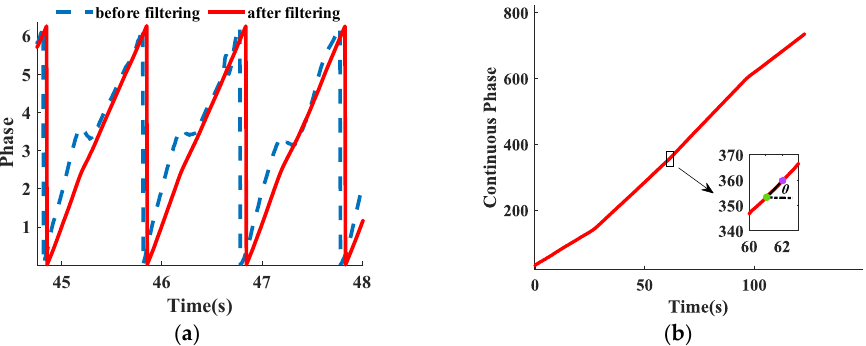
Figure 2. ( a ) Phase-time diagram before filtering and after filtering. ( b ) The y-axis shows the continuous phase and the x-axis is time.